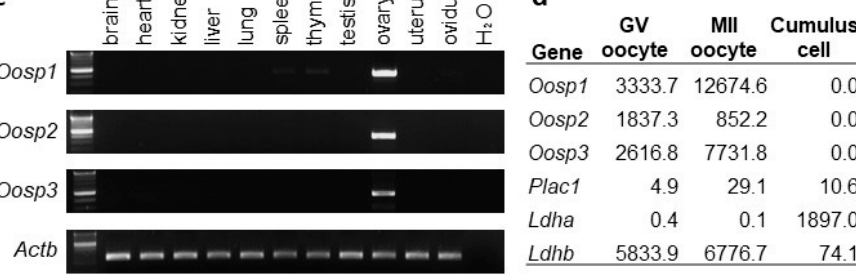
Figure 1. Conservation of Oosp family genes between species and tissue expression analysis. ( a ) Phylogenetic trees. ( b ) Amino acid homology between OOSP family. All four genes have a signal peptide sequence as coded by amino acids 1-21. ( c ) RT-PCR analysis using multiple tissues. Actin beta ( Actb ) was used as the control. ( d ) Expression levels in germinal vesicle (GV) oocytes, metaphase II (MII) oocytes, and cumulus cells. Ldha and Ldhb are shown as the control. FPKM: fragments per kilobase of exon per million reads